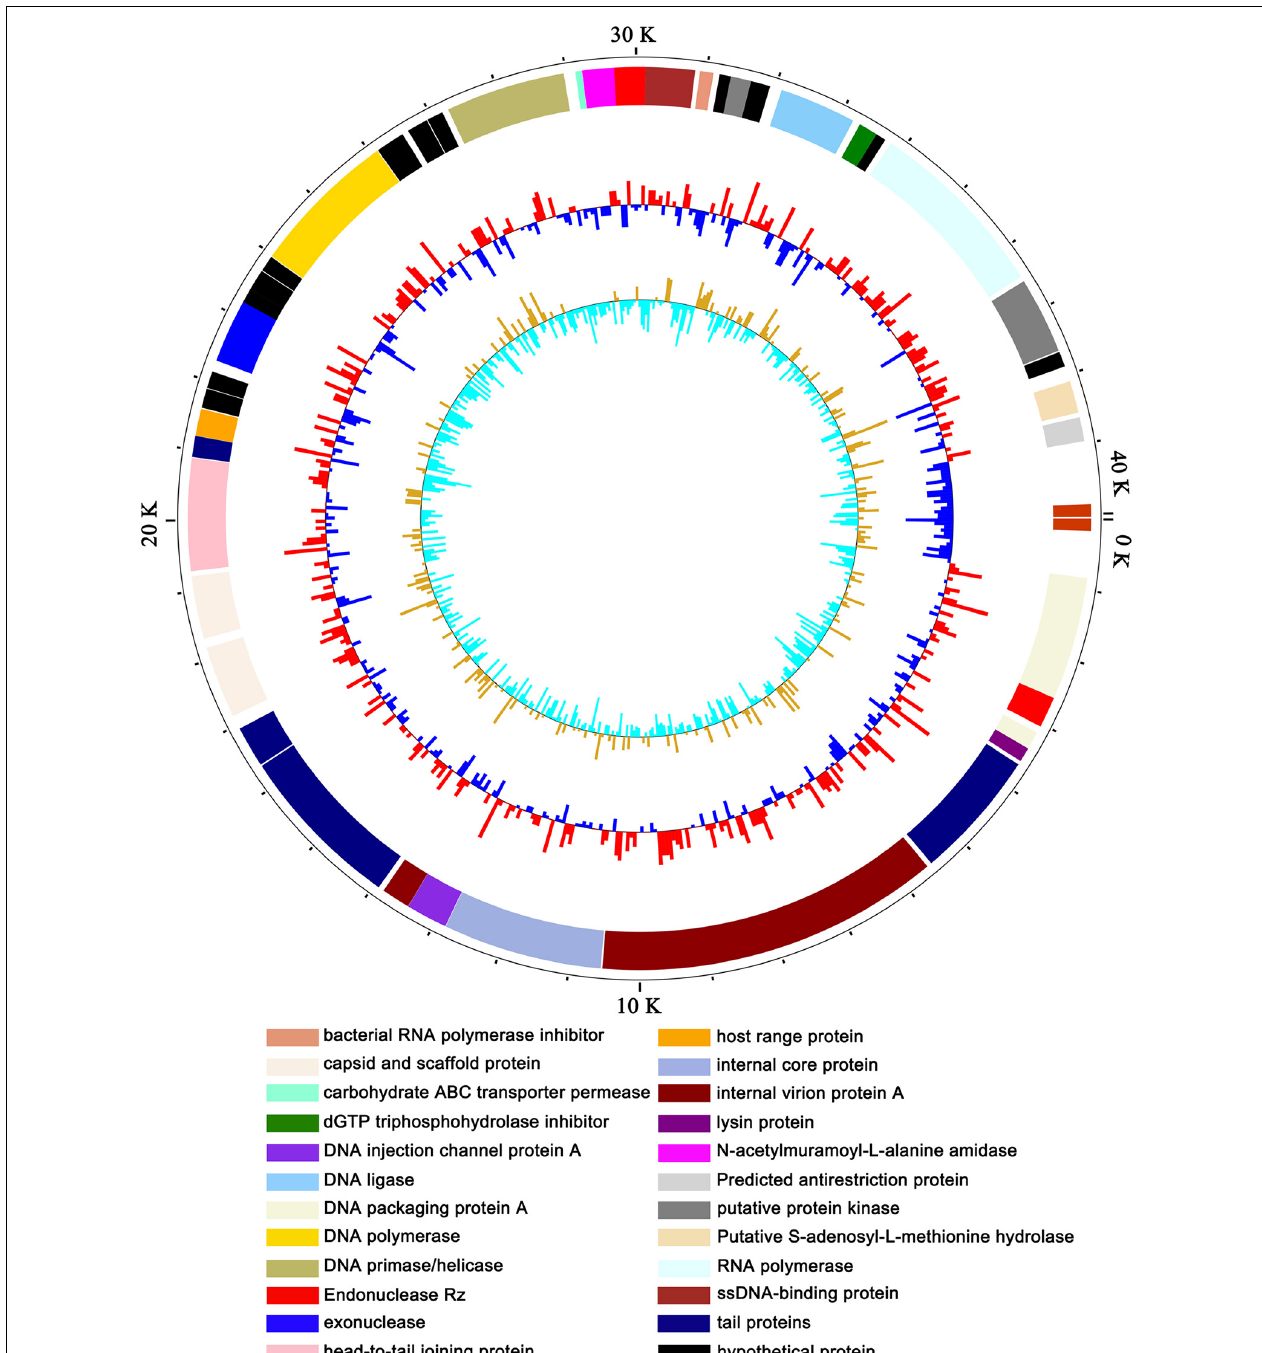
FIGURE 3 | Map of the genome organization of bacteriophage vB_ShiP-A7. The predicted ORFs of vB_ShiP-A7 are indicated in different colors in the outermost ring. All of the ORFs predicted in the vB_ShiP-A7 genome were in negative strand. ORFs with predicted functions are marked in different colors. Hypothetical proteins are labelled in black. The second ring represents the GC content. Red outward indicates that the GC content is above average, and blue inward indicates that the GC content is below average. The innermost ring represents the GC skew.